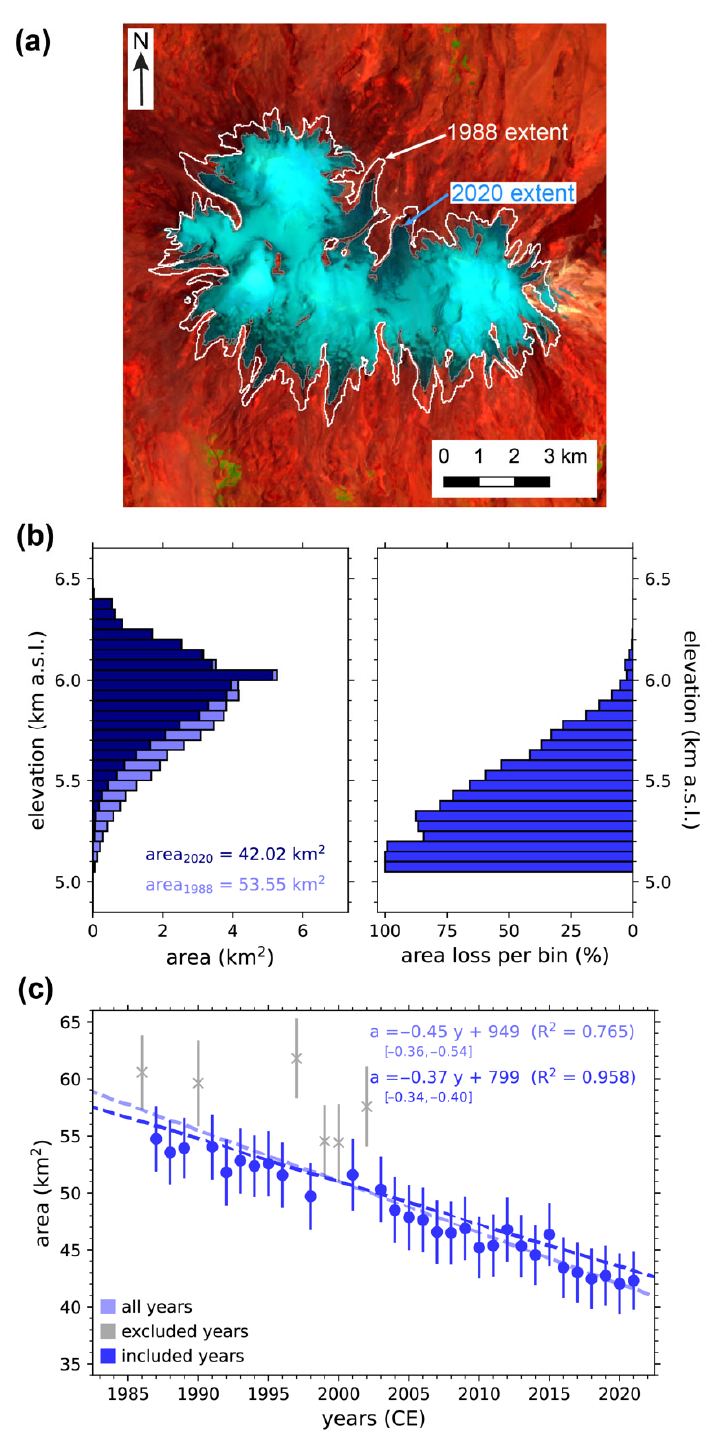
Figure 3. Changes at Nevado Coropuna ( a ) in map view, ( b ) with respect to elevation in 50 m elevation bins, and ( c ) over time. The Landsat scene for ( a ) is a false-color composite of the scene with the minimum area in 2020 (15 December), and the white outline is the 1988 extent for the scene with the minimum area (29 November). In ( c ), six years with anomalously larger ice cap areas are excluded (gray x’s), and linear regressions results are displayed for the remaining 22 years and the entire dataset, including the 95% confidence intervals inside the square bracket. The 2- σ uncertainty intervals are indicated by the error